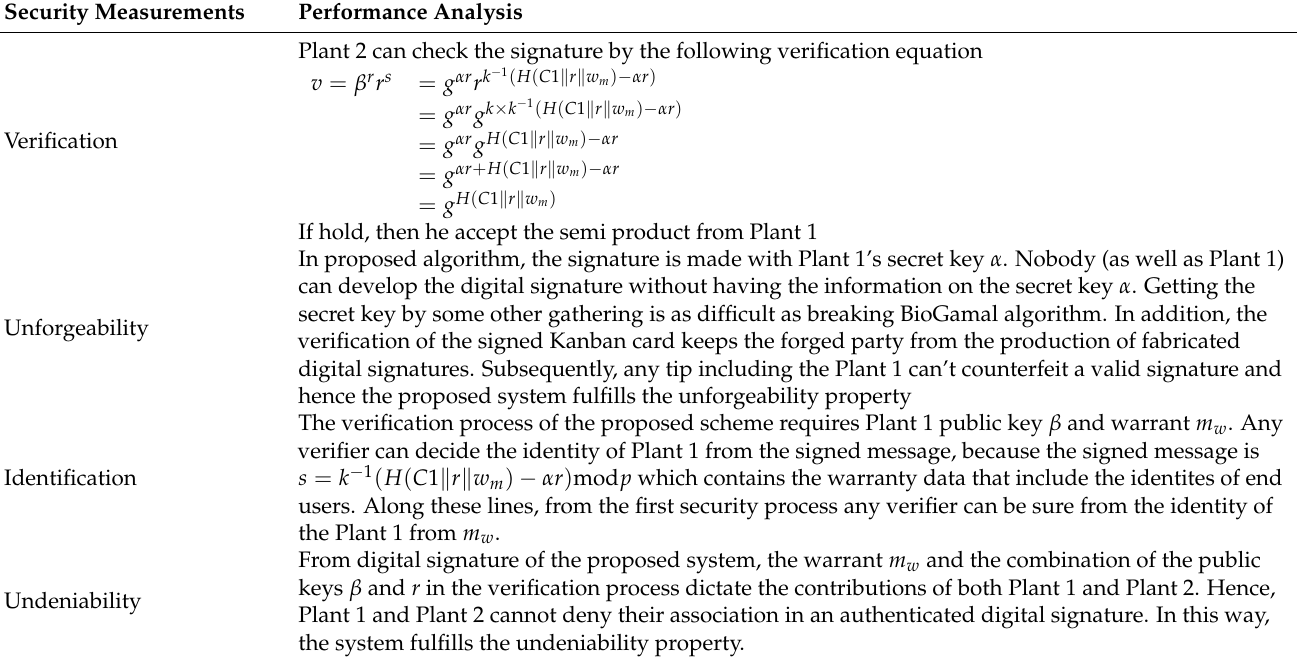
Table 2. Security measurements of the pull manufacturing